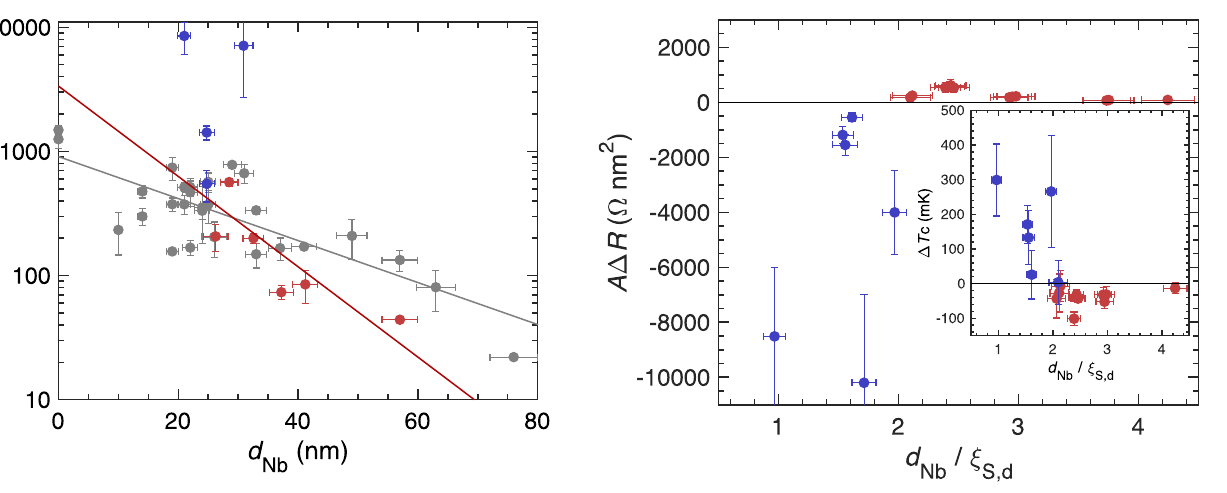
Fig. 5 Normalised thickness dependent crossover of superconducting state behaviour. A Δ R (device area A , magnetoresistance Δ R ) at T / T = 0.3 vs. d ξ T is temperature and T S , d , where device Nb / device is the onset temperature of the device transition, d Nb is Nb thickness and ξ S , d is dirty limit coherence length. The inset is the difference between superconducting critical temperatures in the parallel and antiparallel states, Δ T c , vs. d Nb / ξ S , d . Red points show quasiparticle giant magnetoresistance dominated behaviour, blue the superconducting spin valve effect dominated behavior. Points represent individual spin-valve devices. Vertical error bars are the measurement uncertainty in A Δ R for each device and horizontal error bars the uncertainty in d Nb . The crossover point between the two behaviours occurs around d Nb = 2 ξ S , d